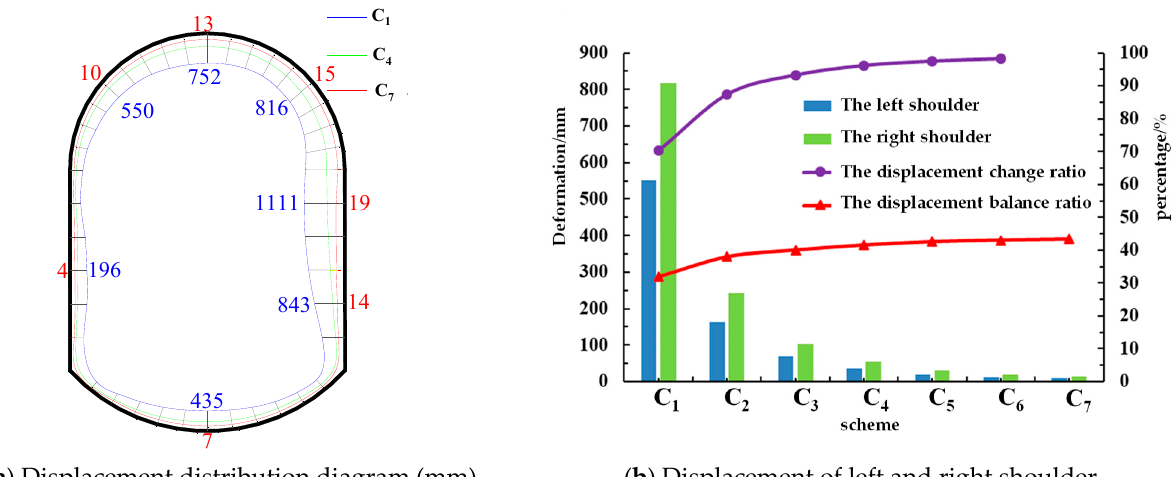
Figure 9. Displacement analysis of different lining thickness. ( a ) Displacement distribution diagram ( b ) Displacement of left and right shoulder